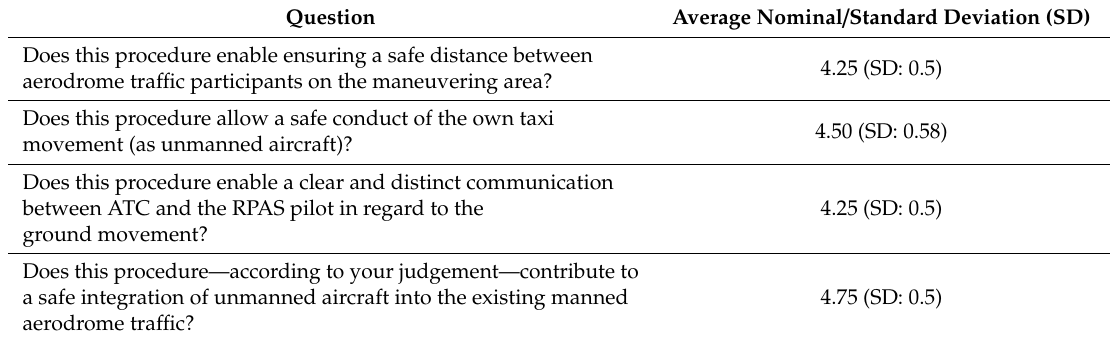
Table 5. Results of tailor-made questionnaires related to safety in nominal situations, answered by RPAS pilots.